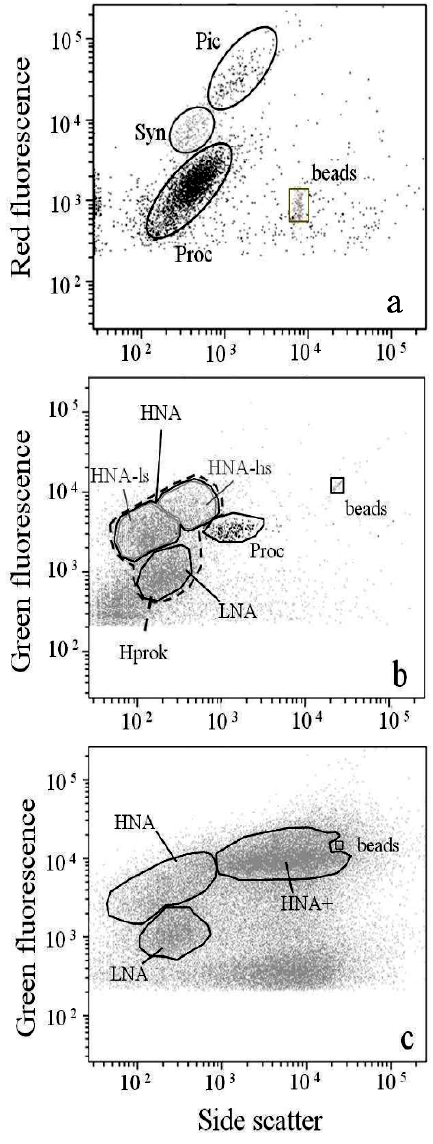
Fig. 2. Examples of flow cytometry biparametric plots of: (a) pho- totrophic groups discriminated by the fluorescence of their pigments and by their side scatter; (b, c) heterotrophic prokaryotic groups discriminated by their SYBR Green I-induced fluorescence versus their side scatter; (b) Heterotrophic prokaryotes and Proc (not ex- cluded to show their localization) from an in situ sample. Sorting gates for HNA-hs, HNA-ls and LNA are shown (continuous lines), as well as limits for the total Hprok flow sorting (as a single sort, dashed line); (c) heterotrophic prokaryotic groups in an enrichment experiment, including HNA+